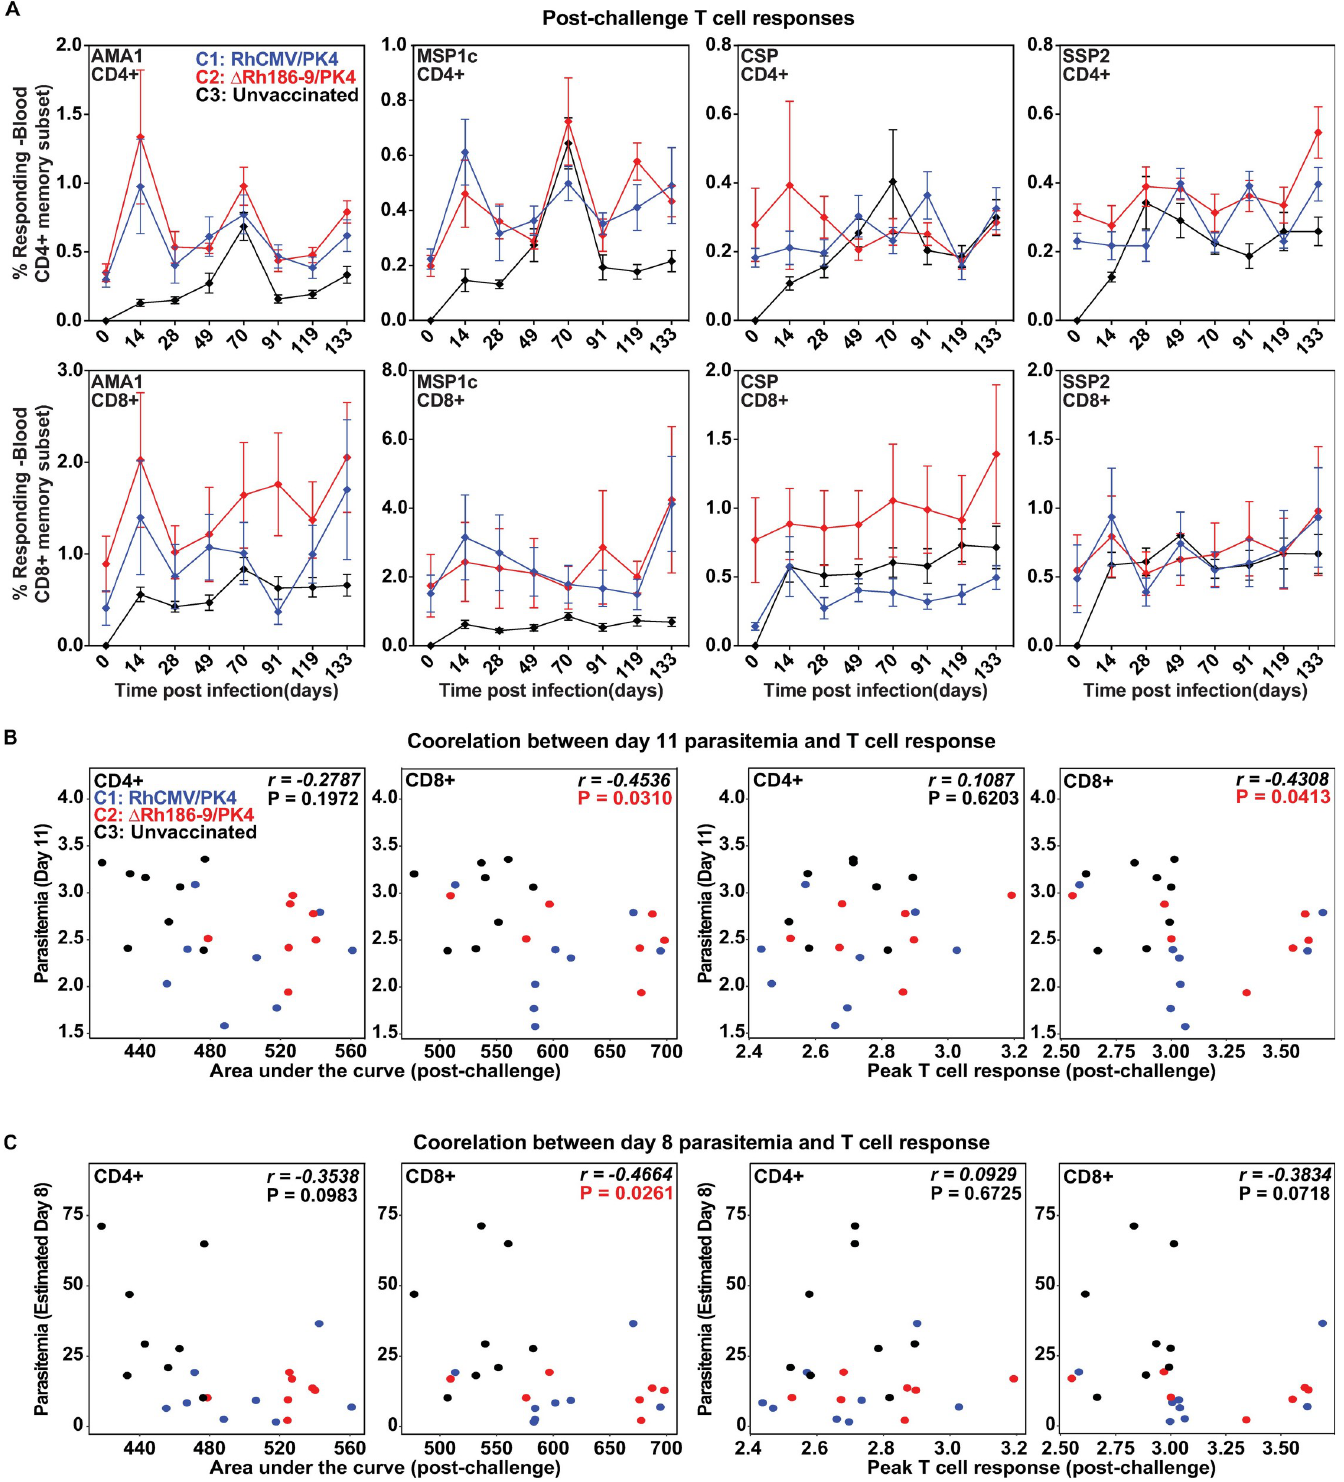
Fig 8. Immune responses in response to parasite challenge. Animals in cohorts 1 and 2 were challenged with 100 PK Spz on day 273 after the first inoculation with RhCMV vectors. Animals in cohort 3 were challenged on the same day. AA) Average CD8+ and CD4+ T cell response frequencies (+/- SD) for each of the four antigens measured in the PBMC of the indicated cohorts by ICS at the indicated time points post-challenge. (B) Post-challenge CD8+ T cell levels correlate with reduced viremia.